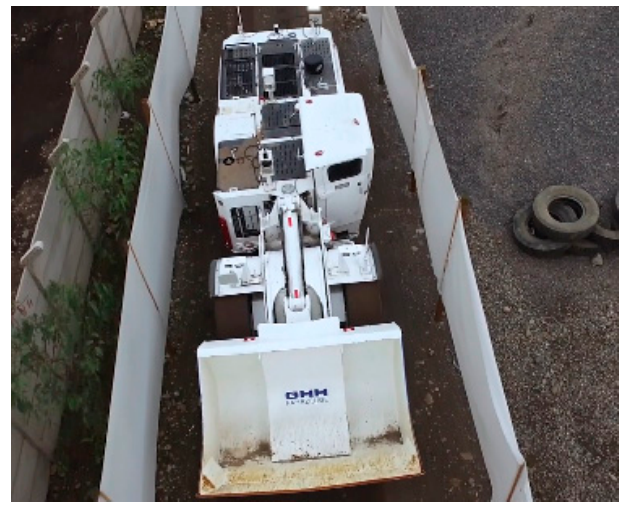
Figure 13. Test-field close to GHH facilities in Santiago de Chile.